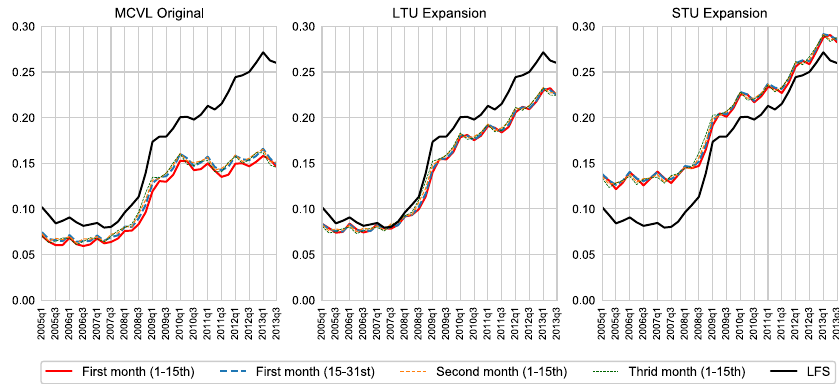
Fig. 14 Changing the reference weeks, by expansion. Source : MCVL and the